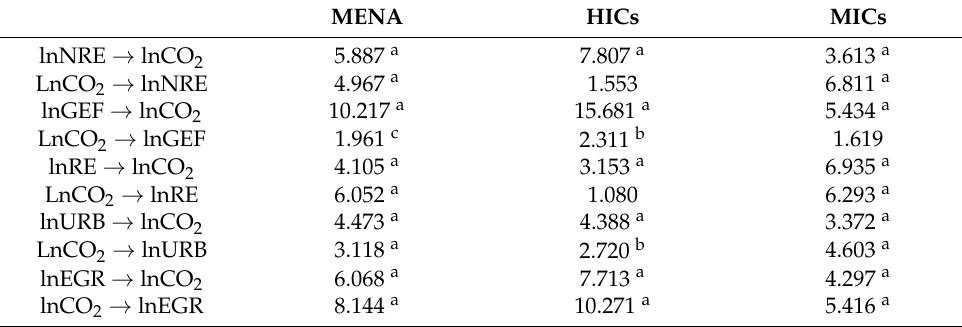
Table 11. Dumitrescu and Hurlin [23] Granger Causality